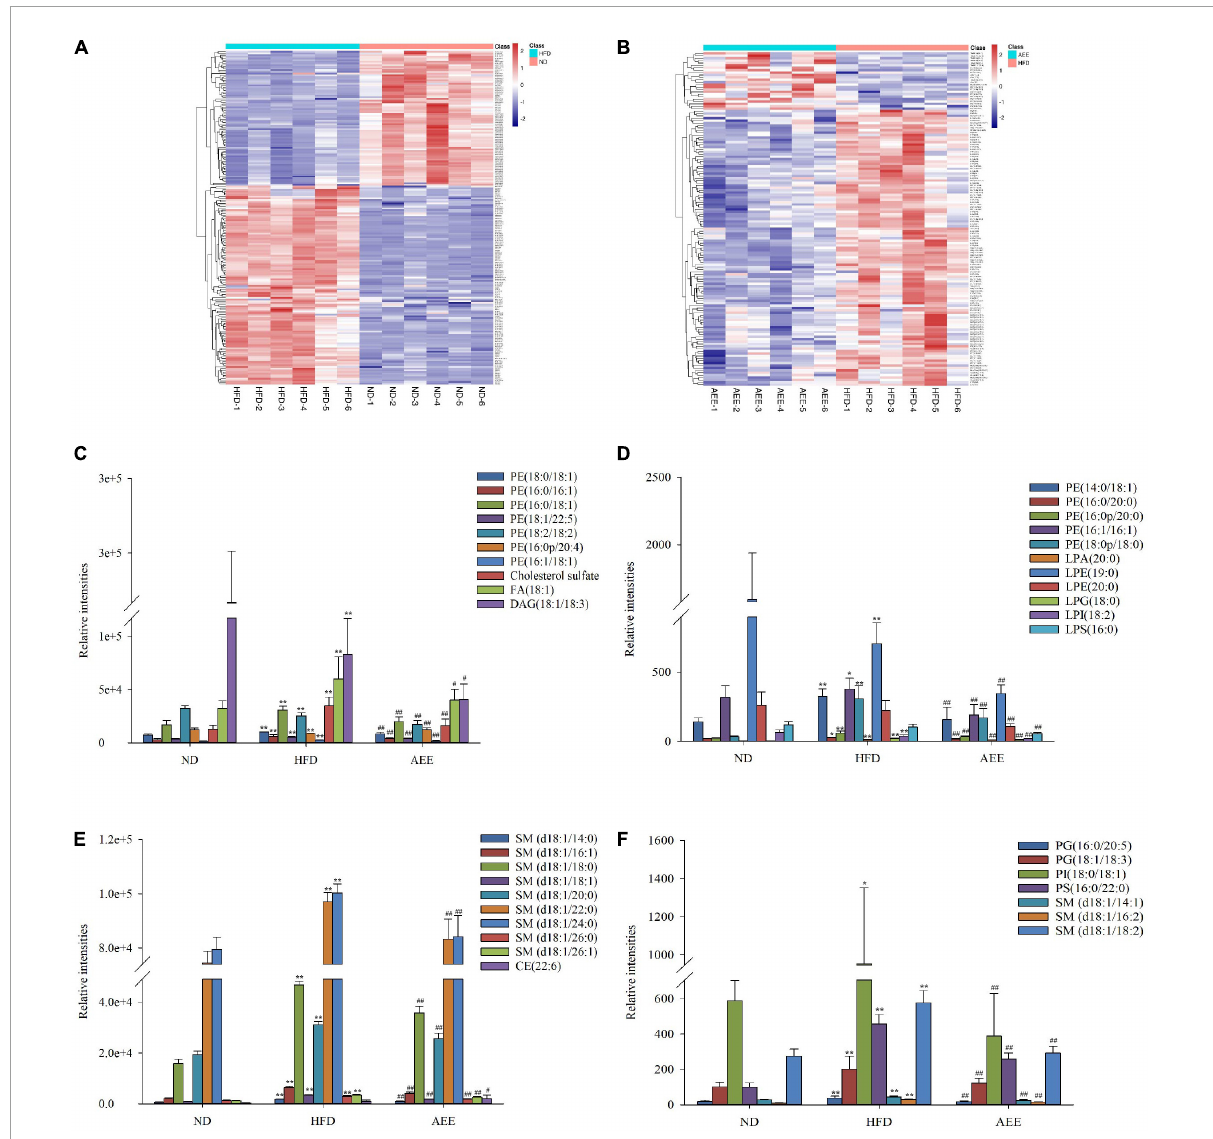
FIGURE4 AEE altered the important differential lipid species in the liver. (A) Different lipids in HFD vs. ND. (B) Different lipids in AEE vs. HFD. (C–F) The important hepatic differential lipid species in the HFD and AEE groups. Data are expressed as the means ± SD ( n = 6). Differences were assessed by ANOVA and denoted as follows: ** P < 0.01, * P < 0.05 compared with the ND group; ## P < 0.01, # P < 0.05 compared with the HFD